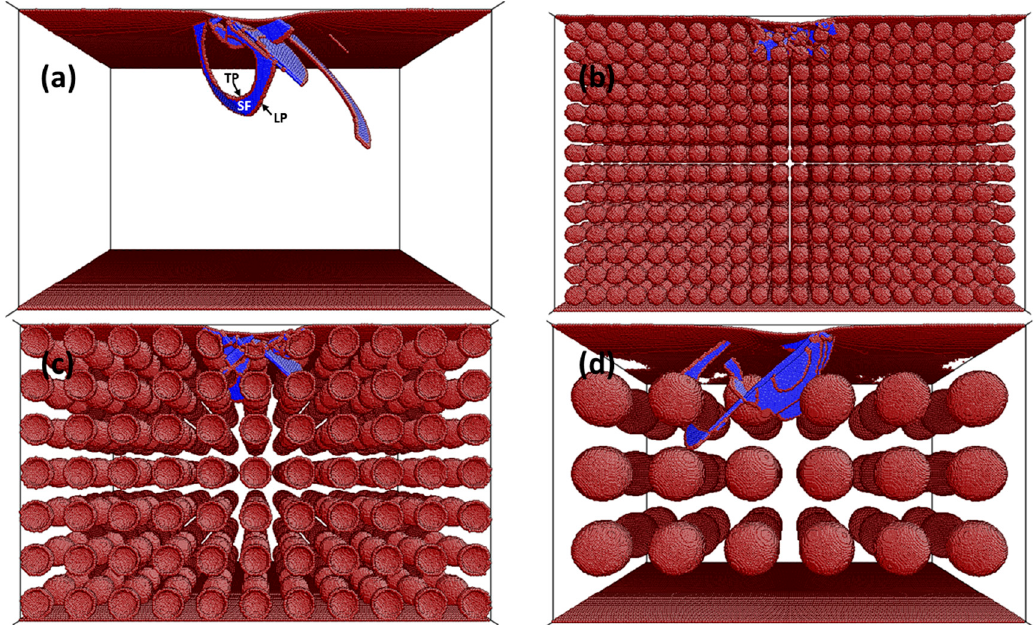
Figure 2. Snapshots showing the dislocation structure at a constant penetration depth ( h s = 15 Å) of spherical MD indentation simulations on (001) Cu single crystals for: ( a ) bulk; ( b ) D p = 2 nm; ( c ) D p = 4 nm; ( d ) D p = 8 nm. The porosity level in panels ( b – d ) is fixed to p = 15%. Panel ( a ) shows the stacking faults (SFs) delimited by leading partial (LP) and trailing partial (TP) dislocations. Dark red color designates atoms with a reduced coordination number.